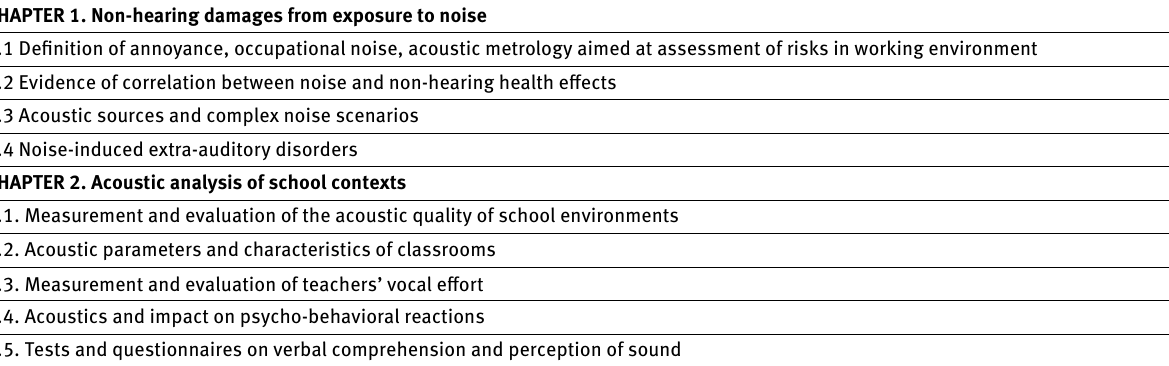
Table 2: Index of guidelines for the prevention of extra-auditory effects CHAPTER 1. Non-hearing damages from exposure to